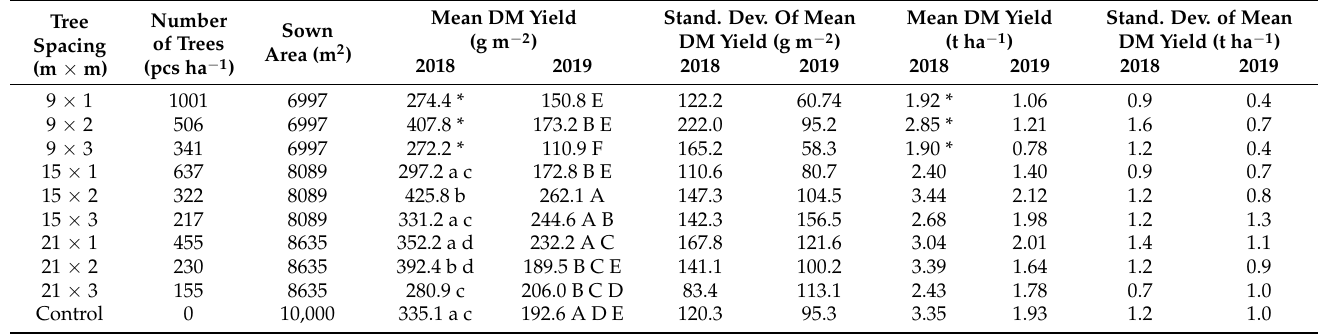
Different letters show significant differences between the treatments. * In 2018, in the treatments of 9 m row space the sowing rate was 220 kg ha − 1 , whereas the rest of the treatments were sown with a sowing rate of 180 kg.